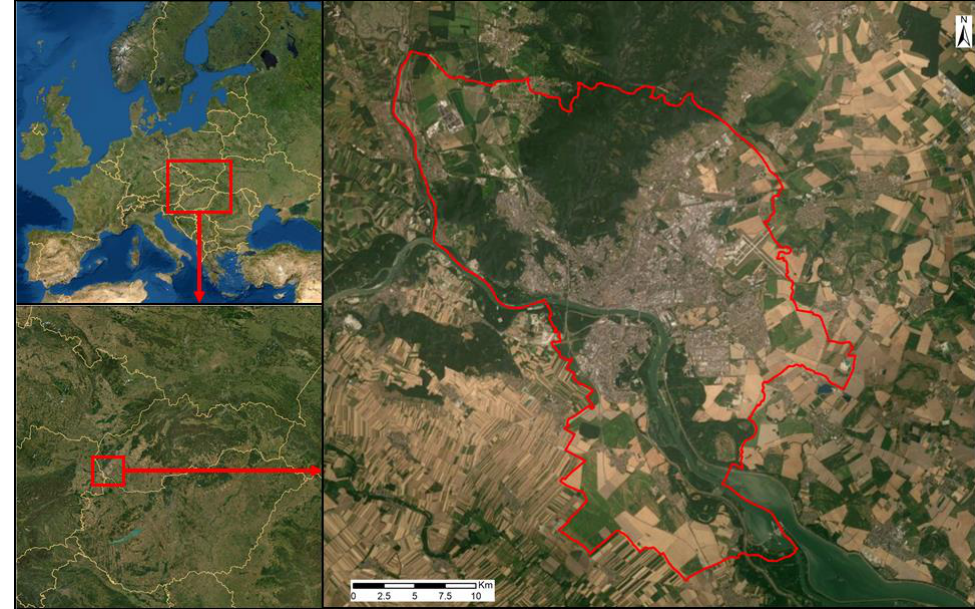
Figure 1. Study area — Bratislava, the capital of the Slovak Republic.